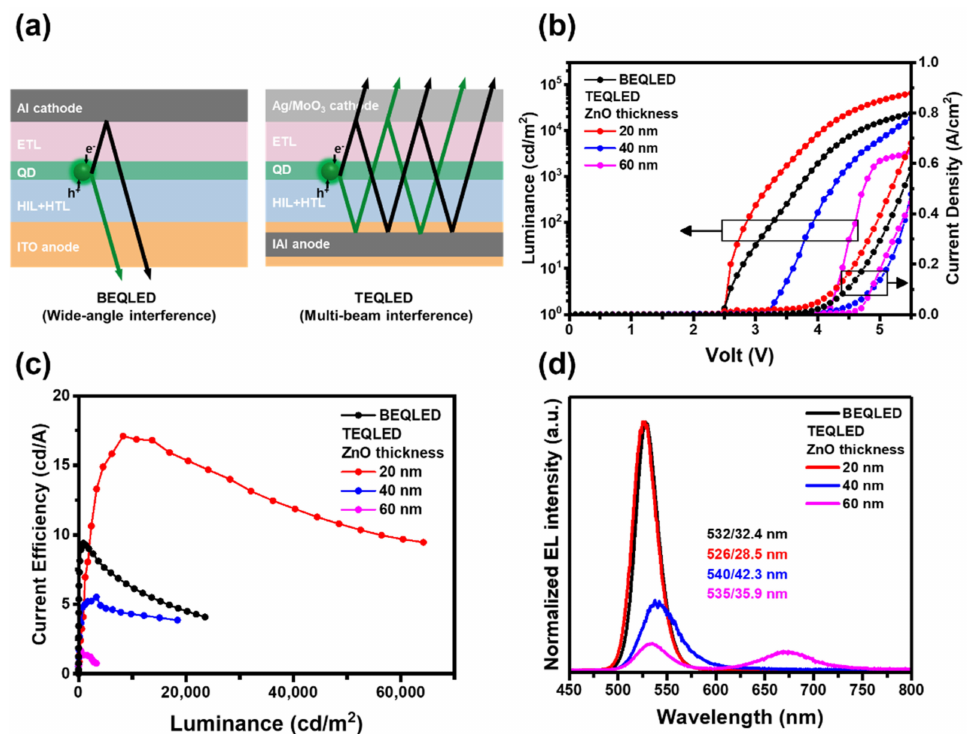
Figure 5. ( a ) Schematic diagram of the light interference modes in BEQLED and TEQLED. ( b ) J – V – L and ( c ) CE – L characteristics, and ( d ) EL spectra of the BEQLED and TEQLEDs with various ZnO thickness. The reference BEQLED consisted of ITO/PEDOT:PSS (40 nm)/PVK (17 nm)/QDs (25 nm)/ZnO (20 nm)/Al (100 nm). The TEQLED structure consisted of IAI anode/PEDOT:PSS (40 nm)/PVK (17 nm)/QDs (25 nm)/ZnO (x nm)/Ag (30 nm)/MoO 3 (30